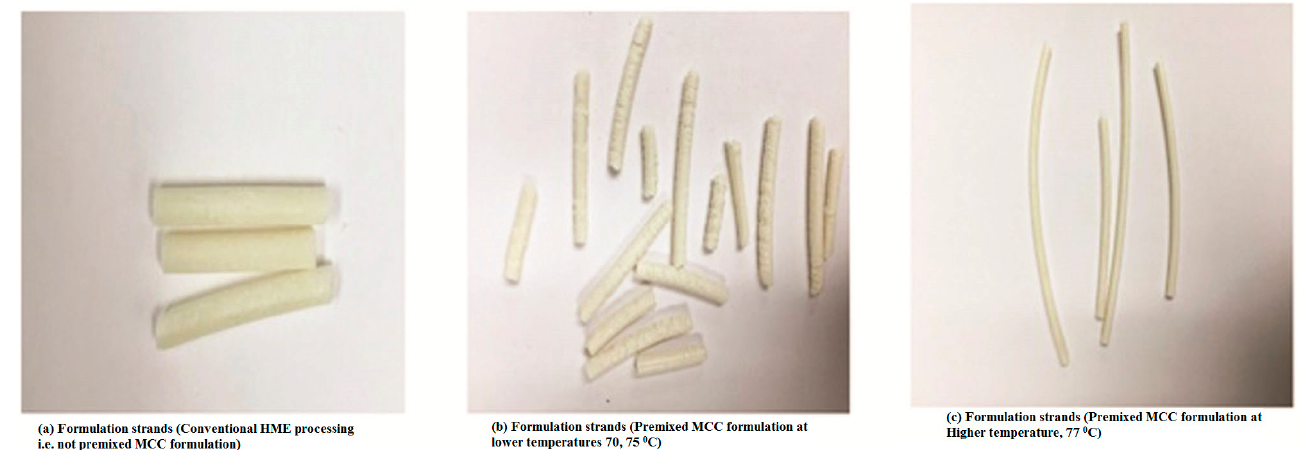
Figure 1. Formulation strand digital pictures.